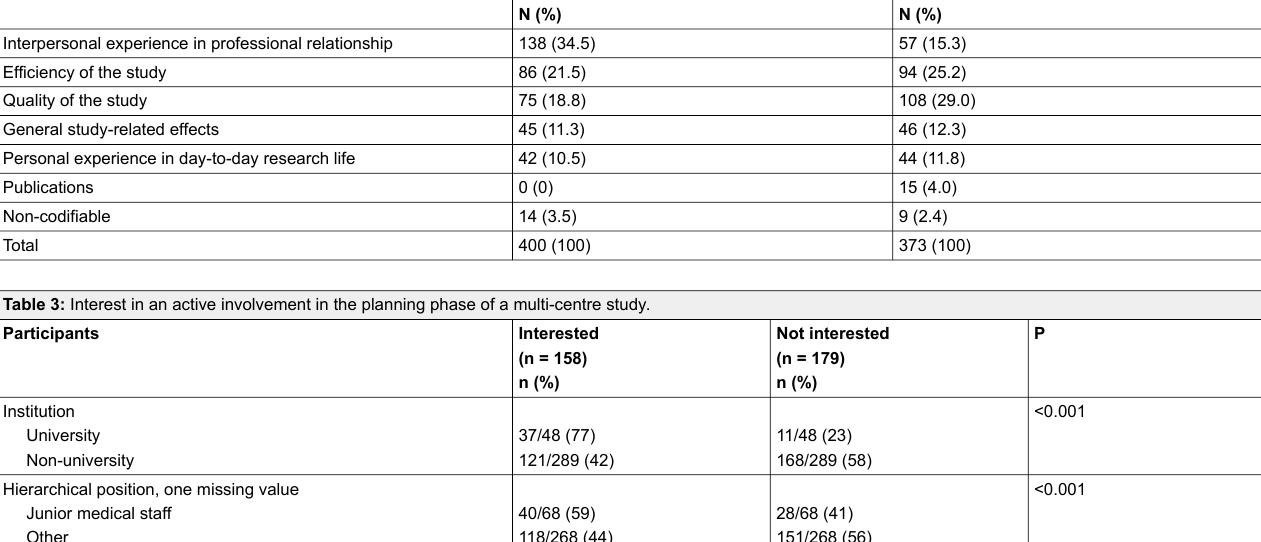
Table 2: Frequency distribution of positive arguments (n = 400 responses) and negative arguments (n = 373 responses) regarding experience with multi-centre studies, ranked by positive arguments.